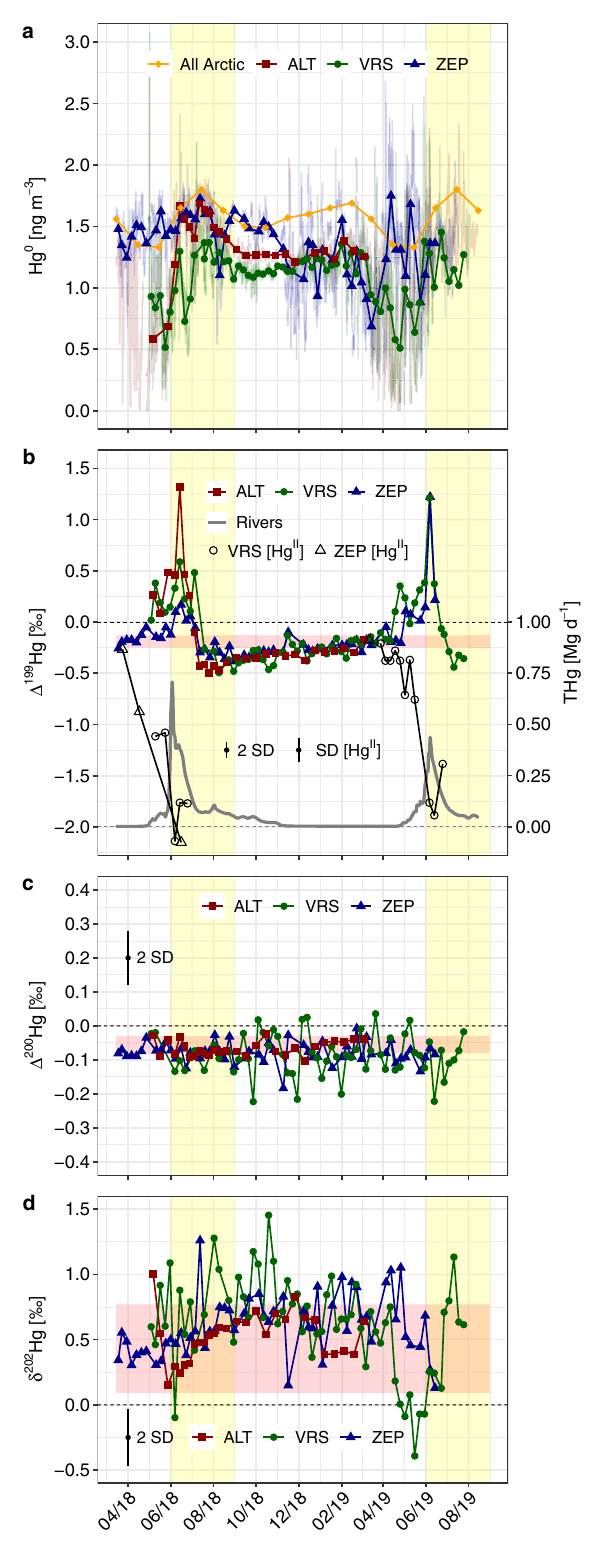
Fig. 2 | Atmospheric Hgand Hgisotope seasonality inthe Arctic. Time series of ( a )Hg 0 concentrations, b Hg 0 andHg II Δ 199 Hg, c Hg 0 Δ 200 Hgand d Hg 0 δ 202 HgatAlert (ALT), Villum (VRS) and Zeppelin (ZEP) research stations. The panel a also shows themonthlymeanlong-term(2000 – 2009)ArcticHg 0 seasonalityforALT,ZEPand Amderma (All Arctic) from 25 , with the summertime Hg 0 maximum highlighted by the yellow shaded areas in all panels (vertical bars). The panel b also shows the predicted daily Eurasian river total Hg fl ux to the Arctic Ocean, based on 34 . Hor- izontal shaded areas (red) are the interquartile range of NH remote atmospheric Hg 0 isotopevariability.Dottedhorizontalblacklinesindicate “ 0permil ” .Theerror bars in b , c , d represent the analytical precision determined as SD (Hg II ) and 2SD (Hg 0 ), respectively from multiple measurements of an in-house